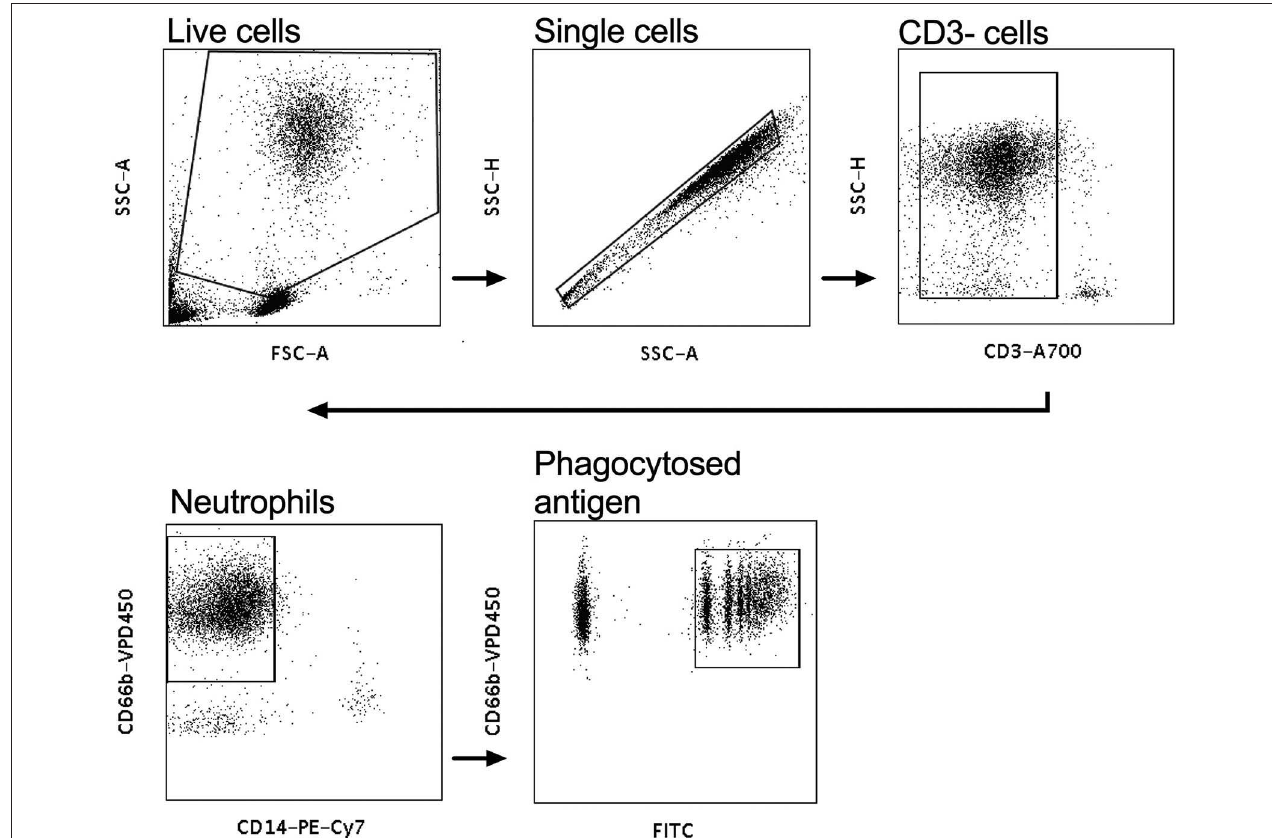
FIGURE 1 | Gating strategy for antibody-dependent neutrophil phagocytic activity (ADNP). White blood cells were gated on, and the CD3 − population selected. CD14 − , CD66 + populations were gated on to identify neutrophils and the CD66 + FITC + cells were gated on to identify phagocytosed neutravidin bound antigen